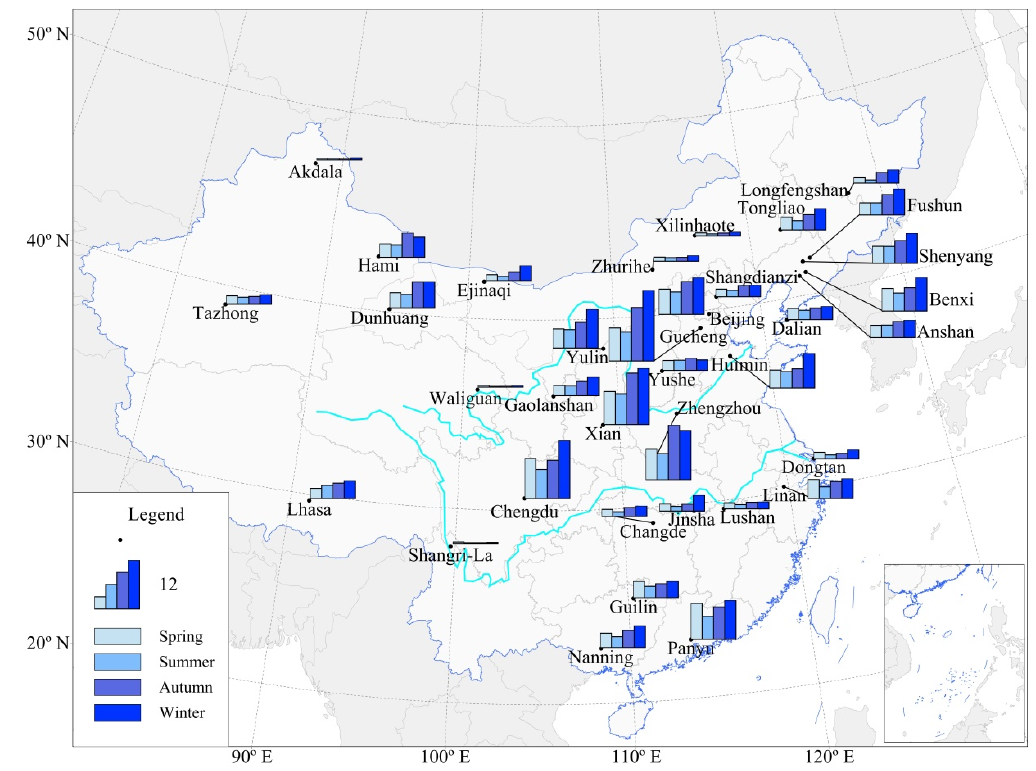
Figure 5. The seasonal average BC concentration from 2006 to 2015, unit: µ g m − 3 .